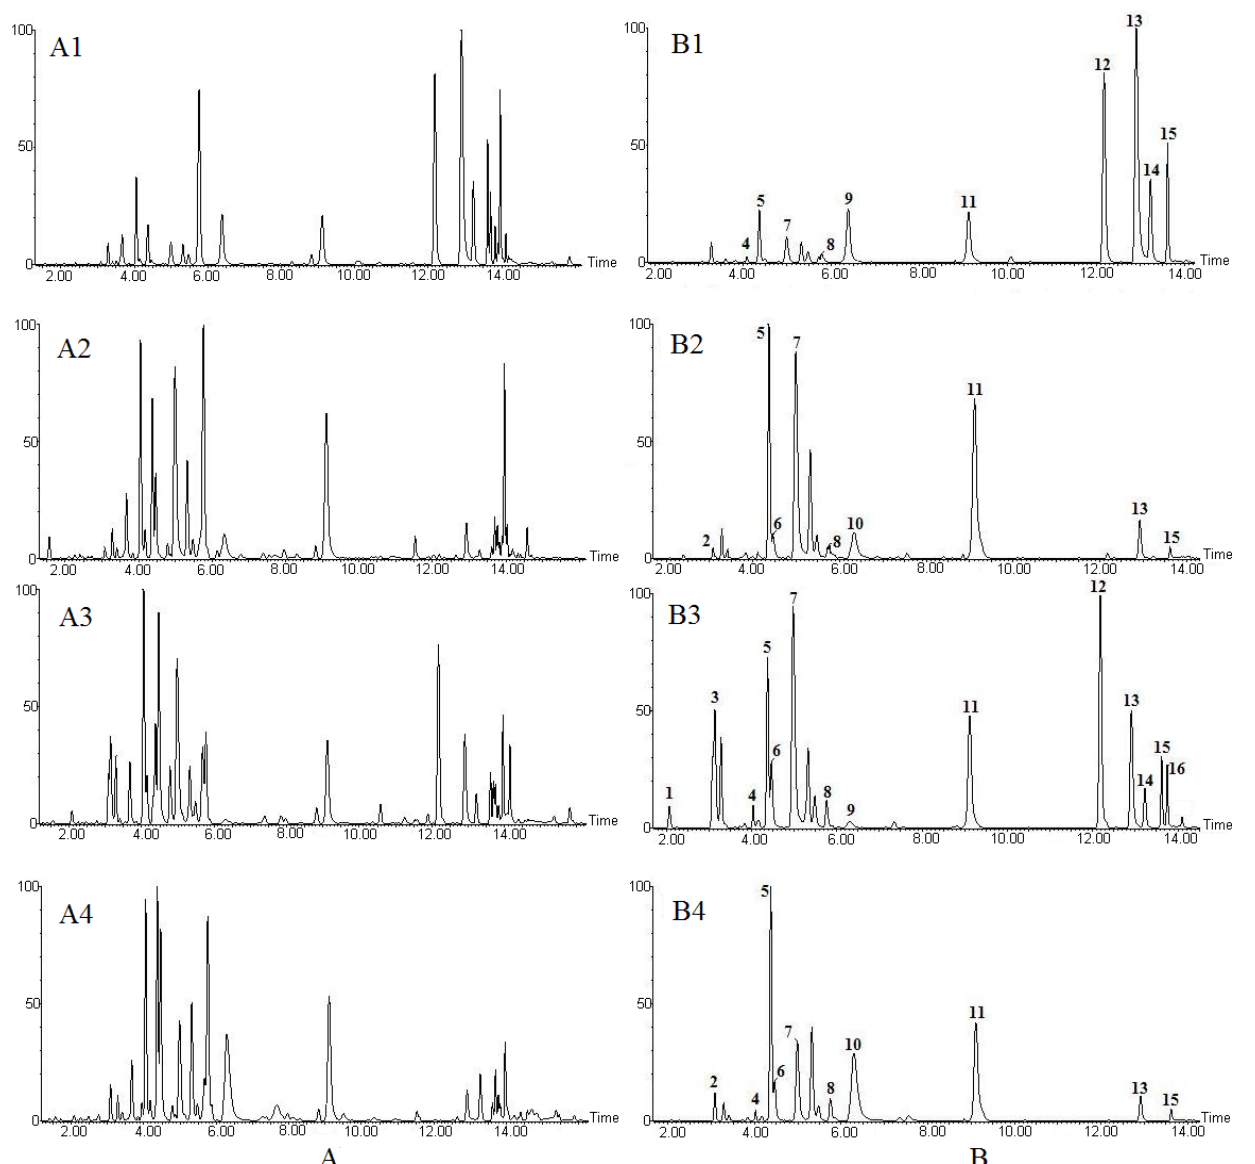
Figure 1. ( A ) UPLC-ESI-MS total ion chromatogram ( B ) and extracted ion chromatogram from Aconitum herbs and processed products. ( A1 , B1 ) Radix Aconiti kusnezoffii , ( A2 , B2 ) Radix Aconiti Kusnezoffii Praeparata , ( A3 , B3 ) Radix Aconiti , and ( A4 , B4 ) Radix Aconiti Praeparata . Peaks 1 to 16 are shown in Table